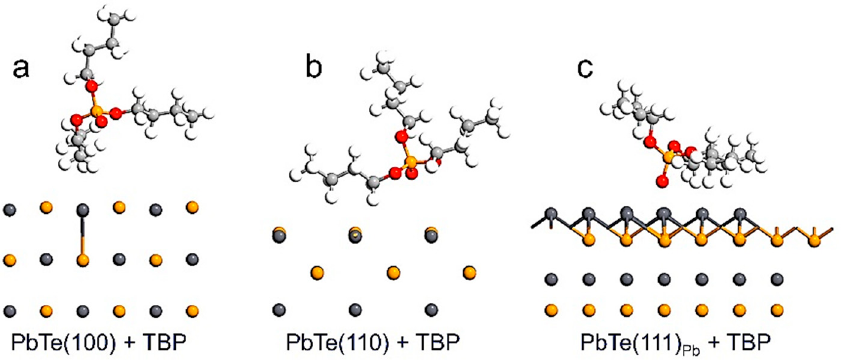
Figure 3. Ground state structures obtained for the TBP molecule interacting with the layer slab models of low-index ( a ) (100), ( b ) (110) and ( c ) (111) Pb surfaces of lead telluride.